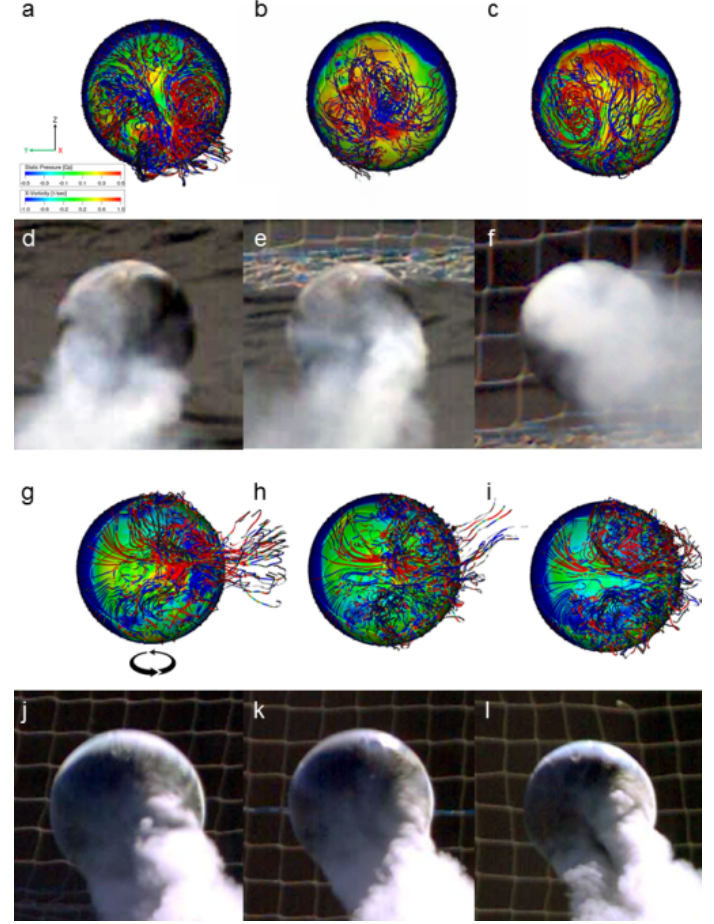
Figure 8. Flow visualization of nonspinning soccer balls using ( a–c ) CFD and ( d–f ) free-flight tests, and that of spinning soccer balls using ( g–i ) CFD and ( j–l ) free-flight tests. The ball spins with a positive rotation about the Z -axis. The Re values for the nonspinning and spinning balls are 2.80 × 10 5 and 4.25 × 10 5 (spin rate = 8 rps), respectively. In the CFD results, the color of the surface of the soccer ball varies according to the pressure coefficient, whereas the color of the streamlines varies according to the vorticity. The view is from behind the ball (back view).